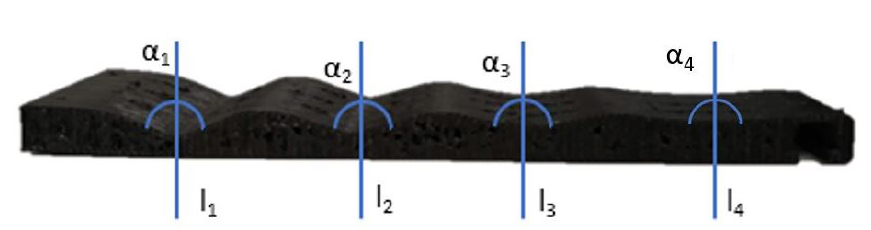
Figure 4. The image shows the final impression of the limb and the different angles chosen in its design.